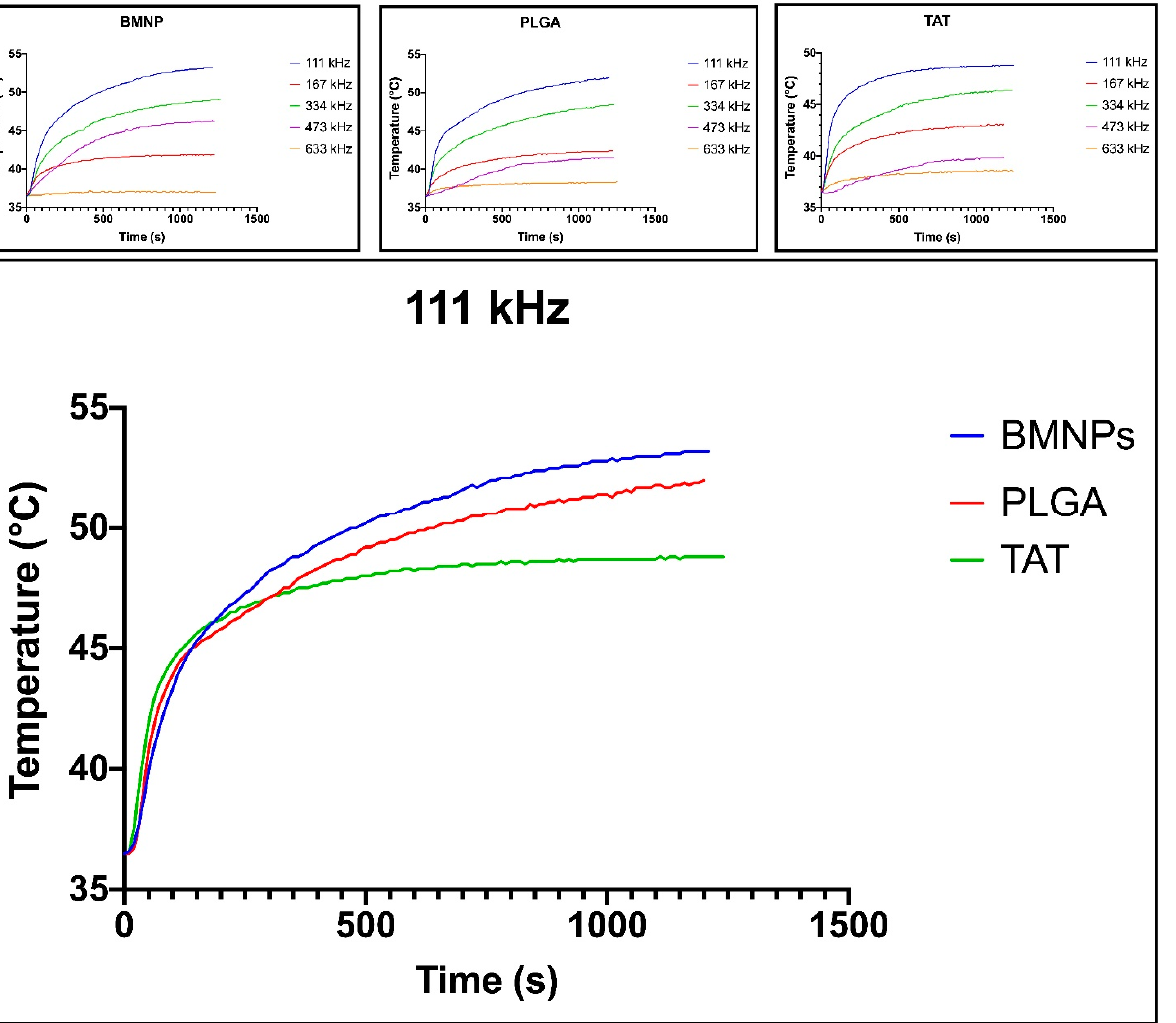
Figure 2. Magnetic hyperthermia data of BMNPs, PLGA(BMNPs) and TAT-PLGA(BMNPs). Hyperthermia efficiency of BMNPs, PLGA-BMNPs and TAT-PLGA-BMNPs on different frequencies (upper part of the figure) and comparison between the different nanoformulation efficiency on the 111 kHz frequency, evaluated using a Nanotherics MagneTherm system.